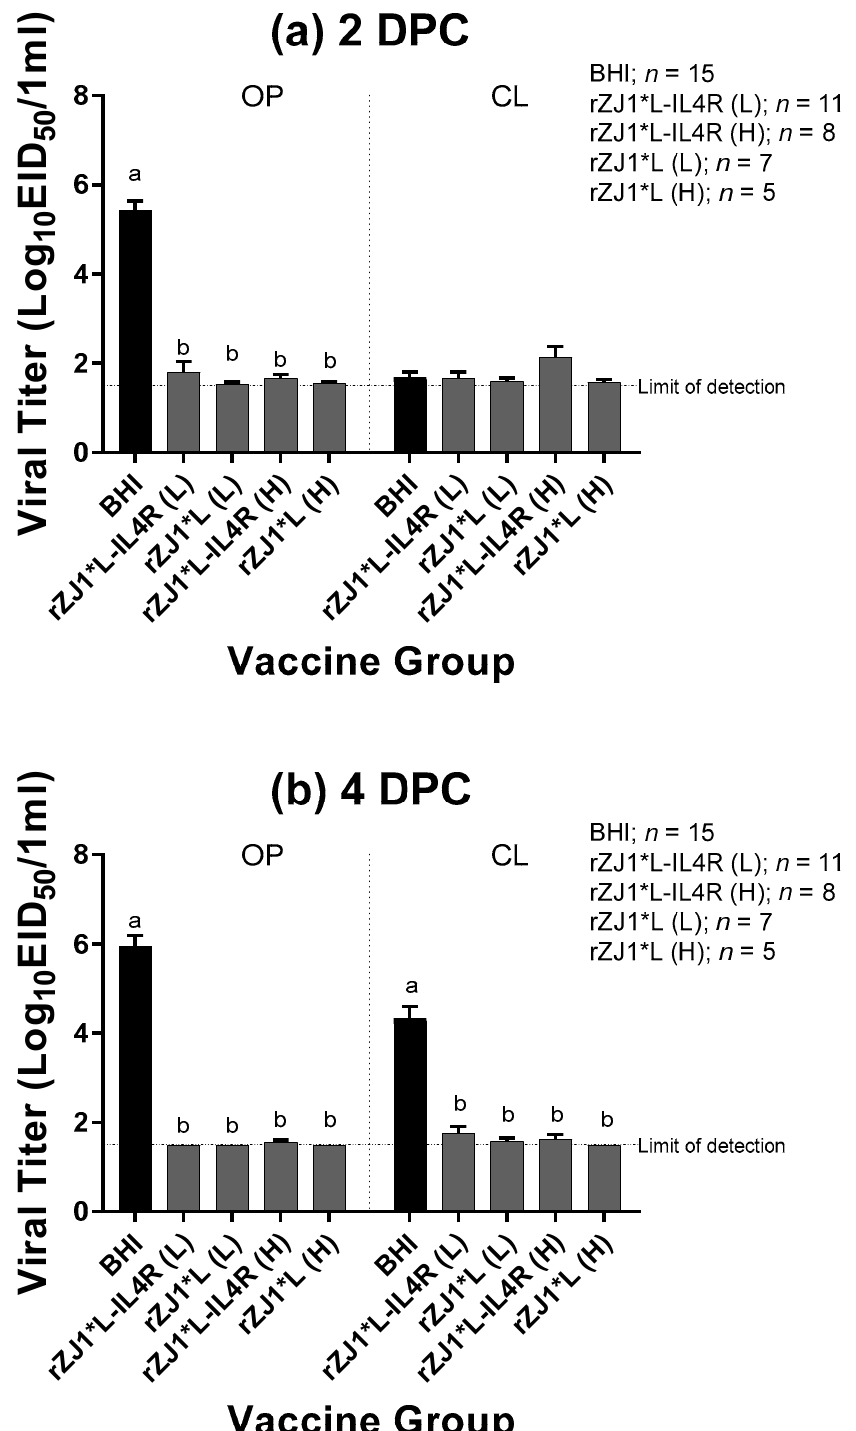
Figure 4. Effect of rZJ1*L-IL4R vaccination at 18 DOE on Post-Challenge Viral Shedding. At 18